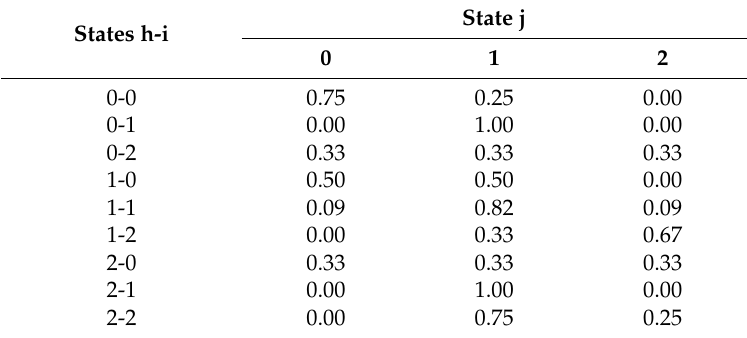
Table 4. Transition probability matrix of the MCSO model leaving the third year out in cross-validation for the period July–August.